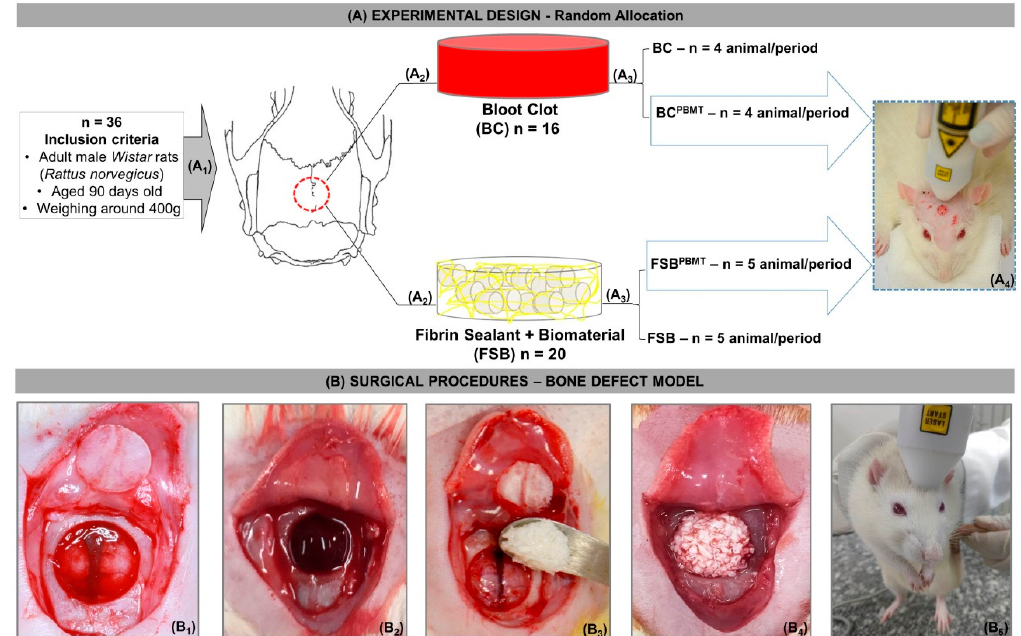
Figure 4. ( A ) Experimental design ( A 1 ) Random allocation: Thirty-six rats were divided into two groups; ( A 2 ) BC ( n = 16)—Blood Clot and FSB ( n = 20)—Fibrin Sealant + Biomaterial; ( A 3 ) After surgical